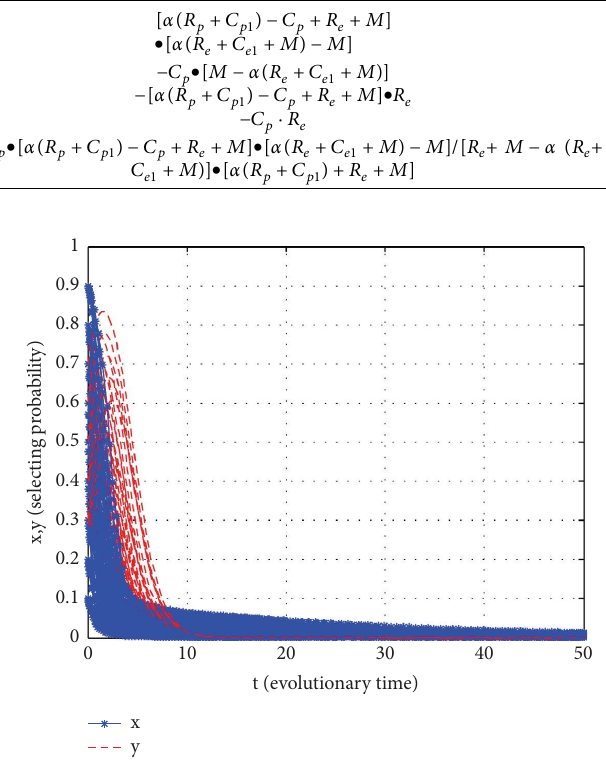
Figure 3: Te evolutionary consequences of Proposition 1.